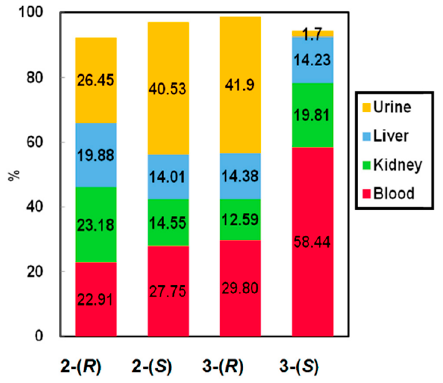
Figure 6. Body distribution of 2 -( R ), 2 -( S ), 3 -( R ) and 3 -( S ) 60 min after intravenous injection into mice (0.10 mmol Gd/kg).